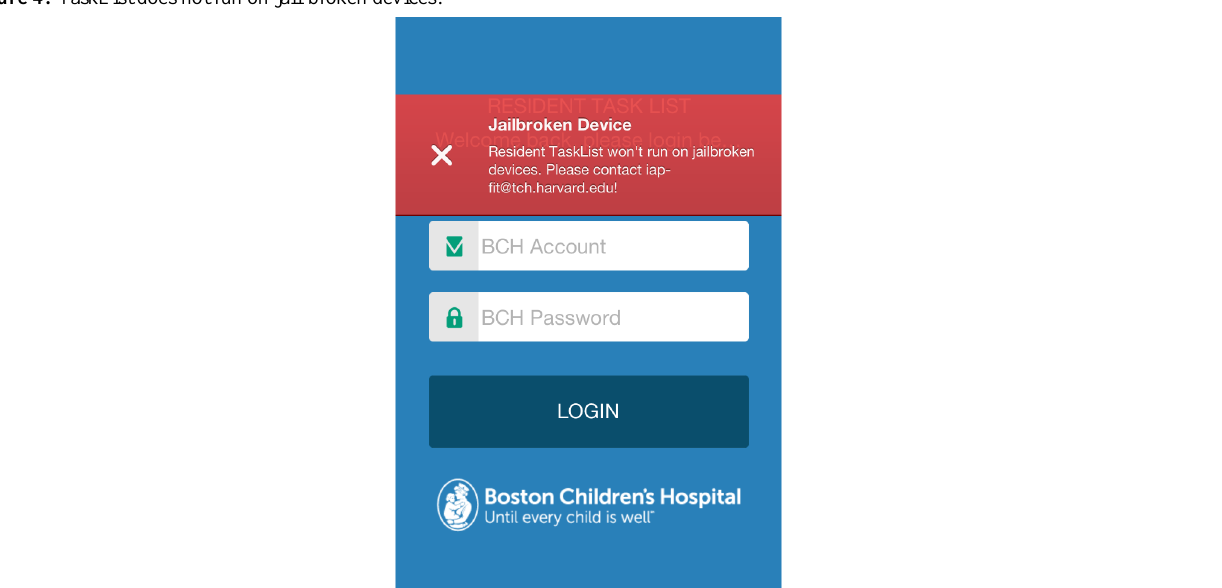
Figure 4. TaskList does not run on jail-broken